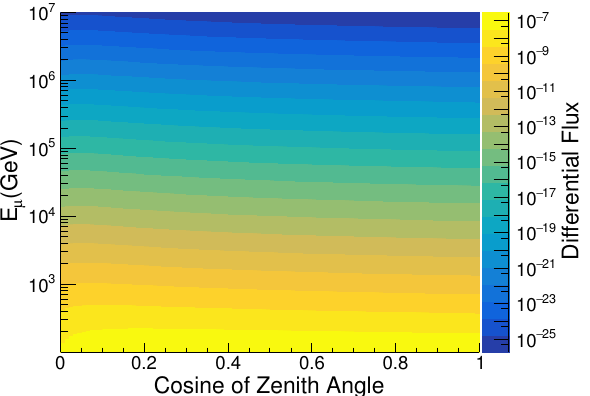
Figure 4. The differential muon flux as a function of cosine of the zenith angle and the energy of the muon as calculated using AMBala at the earth’s